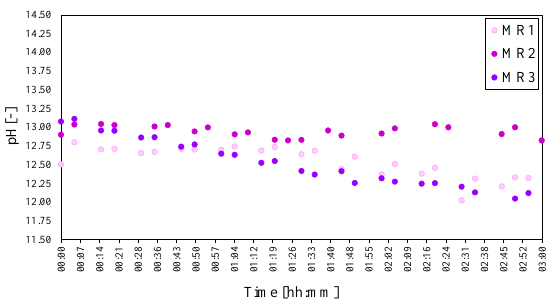
Figure 13. pHs of the molar calcium-to-aluminium series of LDHs MR1 = 3:2, MR2 = 4:2 and MR3 = 6:2. The pH was adjusted to 25 ◦ C to facilitate